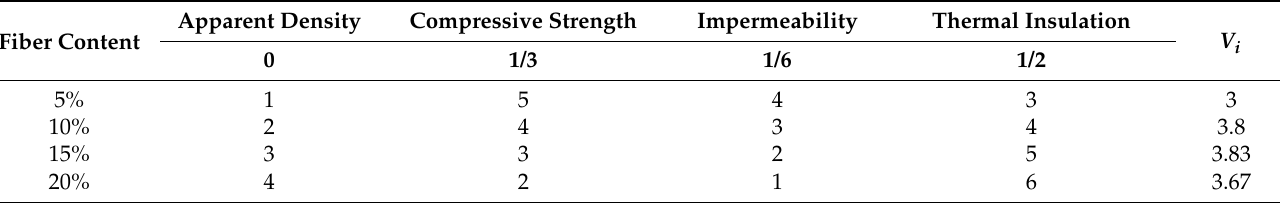
Table 6. Systematic evaluation correlation